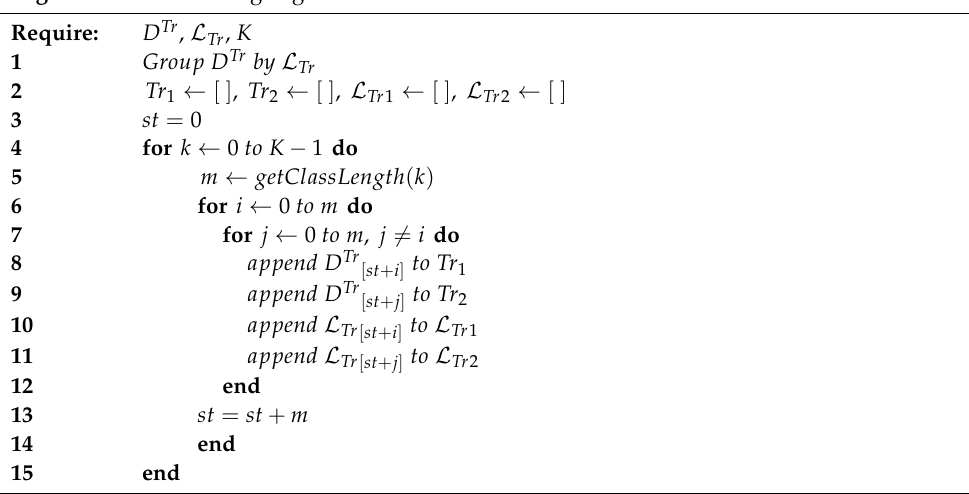
Algorithm 1. The Pairing